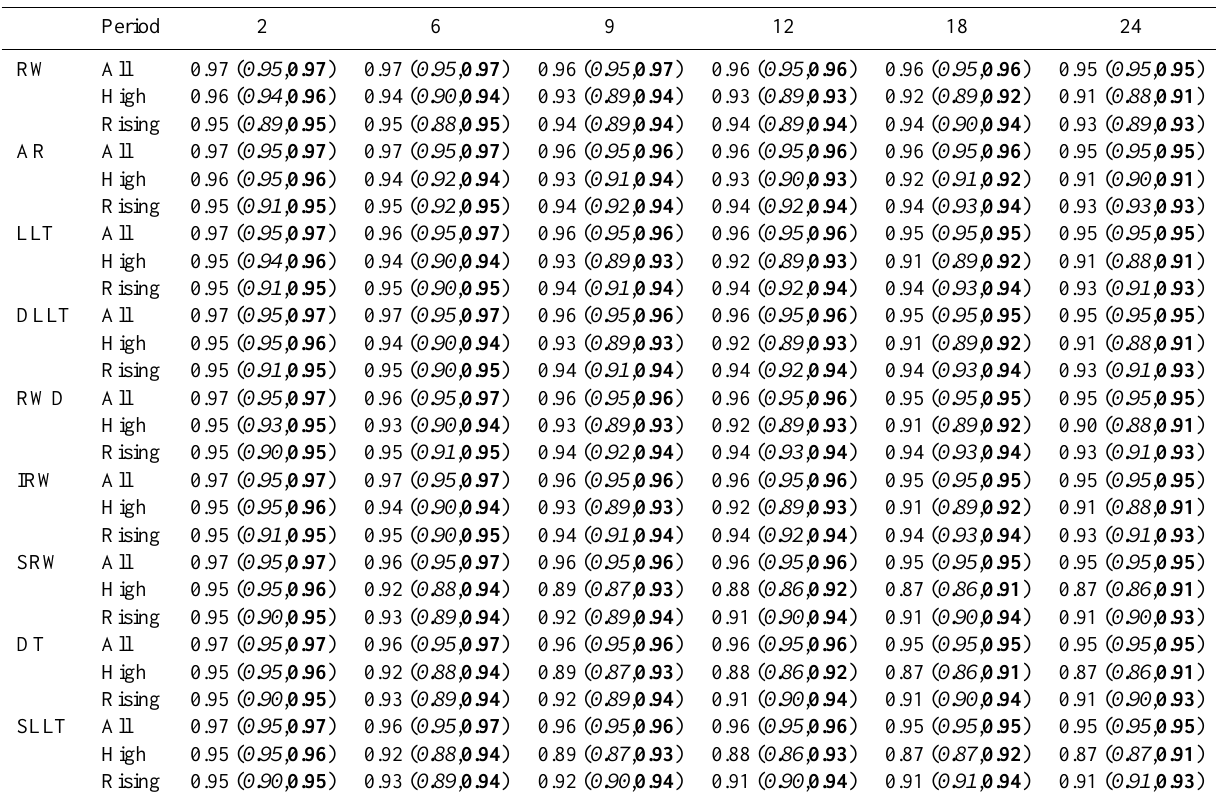
Table 7. Fraction of observations at Llandrinio bracketed by the estimated 95% prediction intervals during calibration. Bracketed results are those for the SEFE calibration with the italicised and bold values corresponding to the empirical and theoretical symmetric bounds. Results are shown for all the time period, high levels ( > 4m) and periods where the hydrograph is rising for different combinations of lead time (hours) and GRW